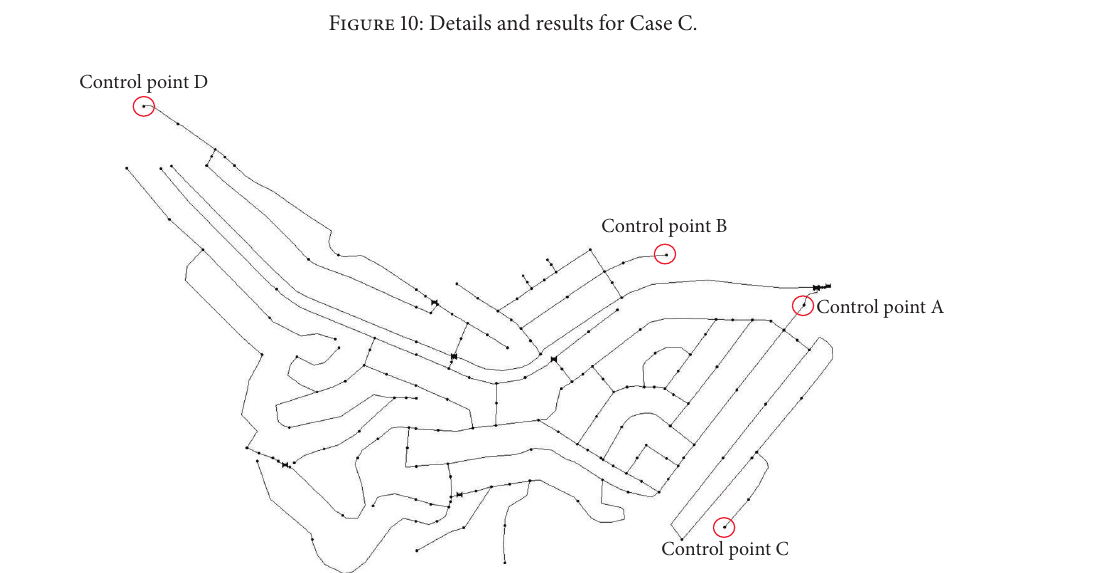
Figure 11: Pressure control